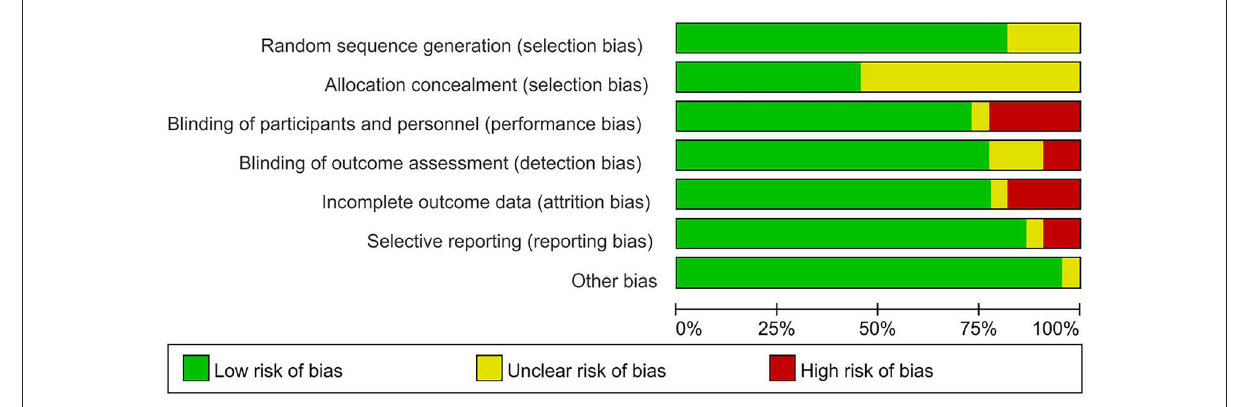
FIGURE8 Risk of bias graph: review authors’ judgements about each risk of bias item presented as percentages across all included